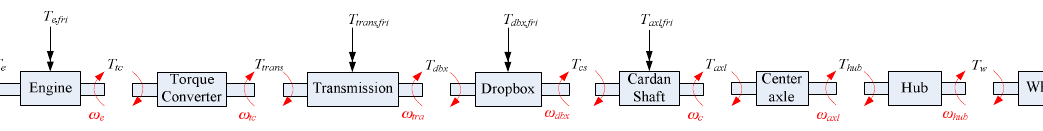
Figure 2. The powertrain of articulated